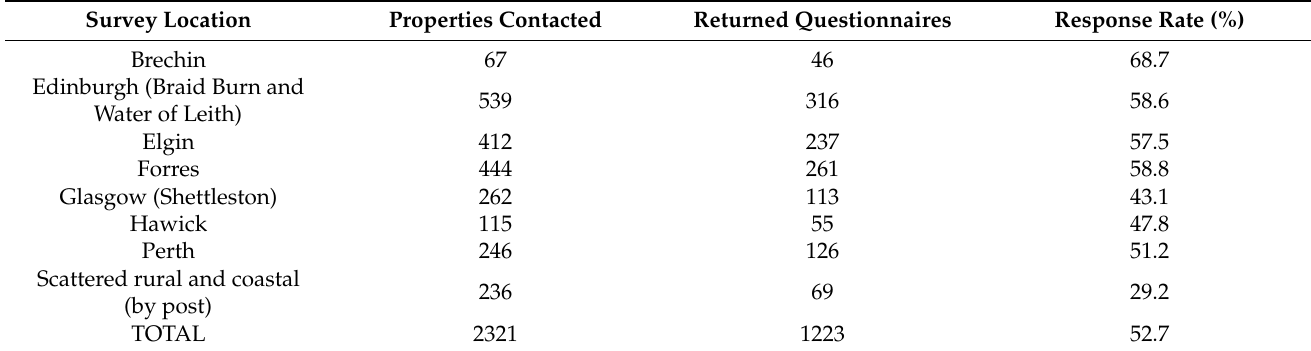
Table 1. Response rates by survey